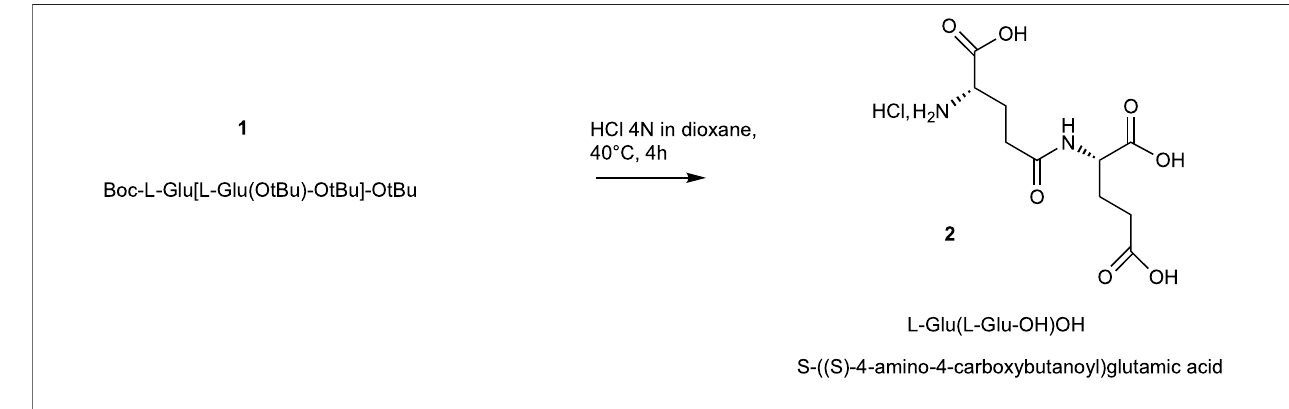
observed in the presence of TTX. In addition, this response